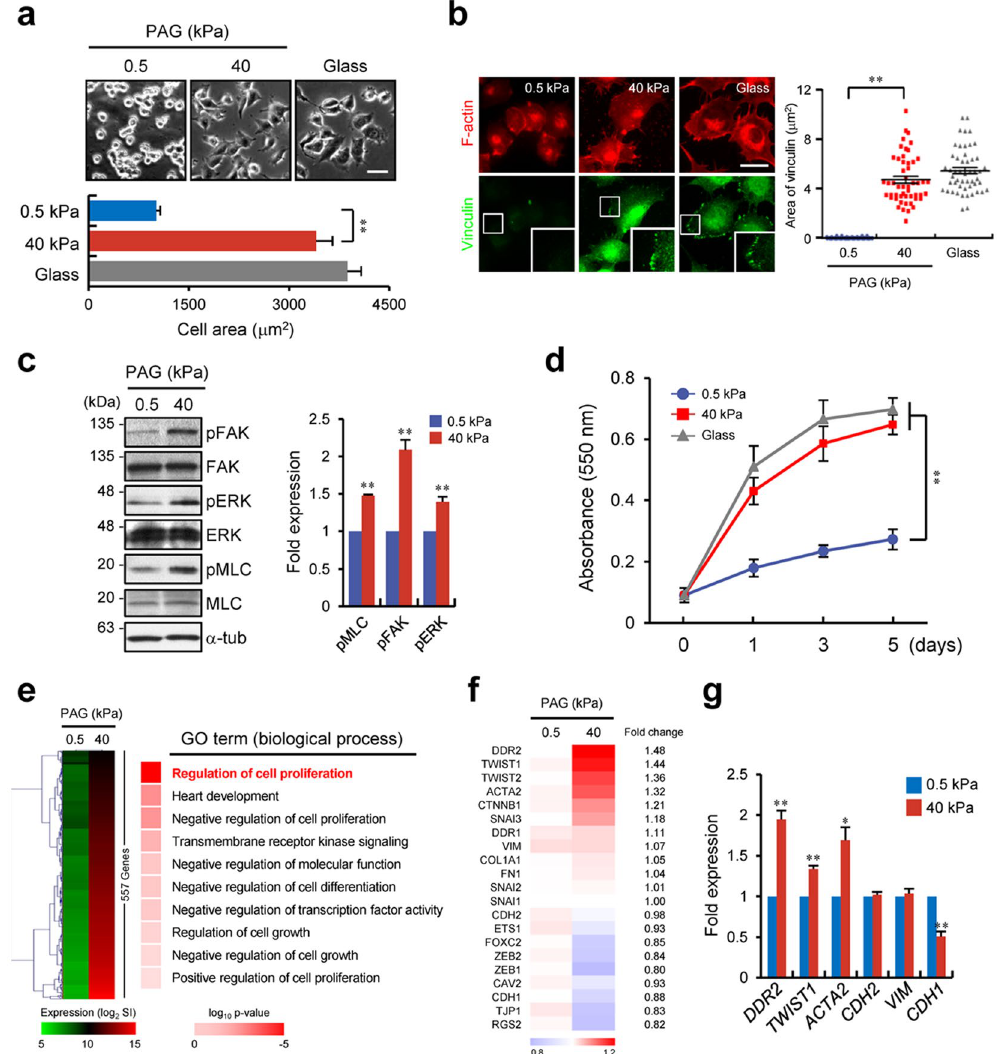
Figure 1. Stiffness of the ECM affects cellular behaviour and gene expression levels. ( a ) Phase contrast images of H1299 cells incubated on PAGs with the indicated stiffness or on glass. Scale bars, 50 μ m. ( b ) Immunostaining of F-actin (red) and vinculin (green) in H1299 cells incubated under the indicated conditions (left); quantification of vinculin (n = 50) area for each condition (right). ( c ) Western blot analysis of pFAK, FAK, pERK, ERK, pMLC, and MLC in H1299 cells incubated under the indicated conditions. ( d ) Quantification of proliferation of H1299 cells incubated on a soft or stiff PAG with the indicated stiffness or on glass for the indicated periods. ( e ) Microarray gene expression analysis of H1299 cells incubated under the indicated conditions for 24 h. Heat map and gene ontology (GO) analysis of gene expression profiles of 557 upregulated genes with a ≥ 1.4 × change in expression. ( f ) Heat map representation of microarray data showing the expression levels of several key EMT-related genes. ( g ) Quantitative RT-PCR (qRT-PCR) analysis of expression of EMT-related genes in H1299 cells incubated on a PAG with 0.5 or 40 kPa stiffness. qRT-PCR values were normalised to GAPDH . Data in ( a ), ( b ), ( c ), ( d ) and ( g ) represent the mean of three independent experiments ± SEM. * P < 0.05, ** P <